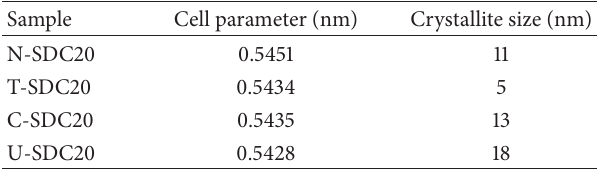
Table 1: Cell parameters and crystal size of the calcined